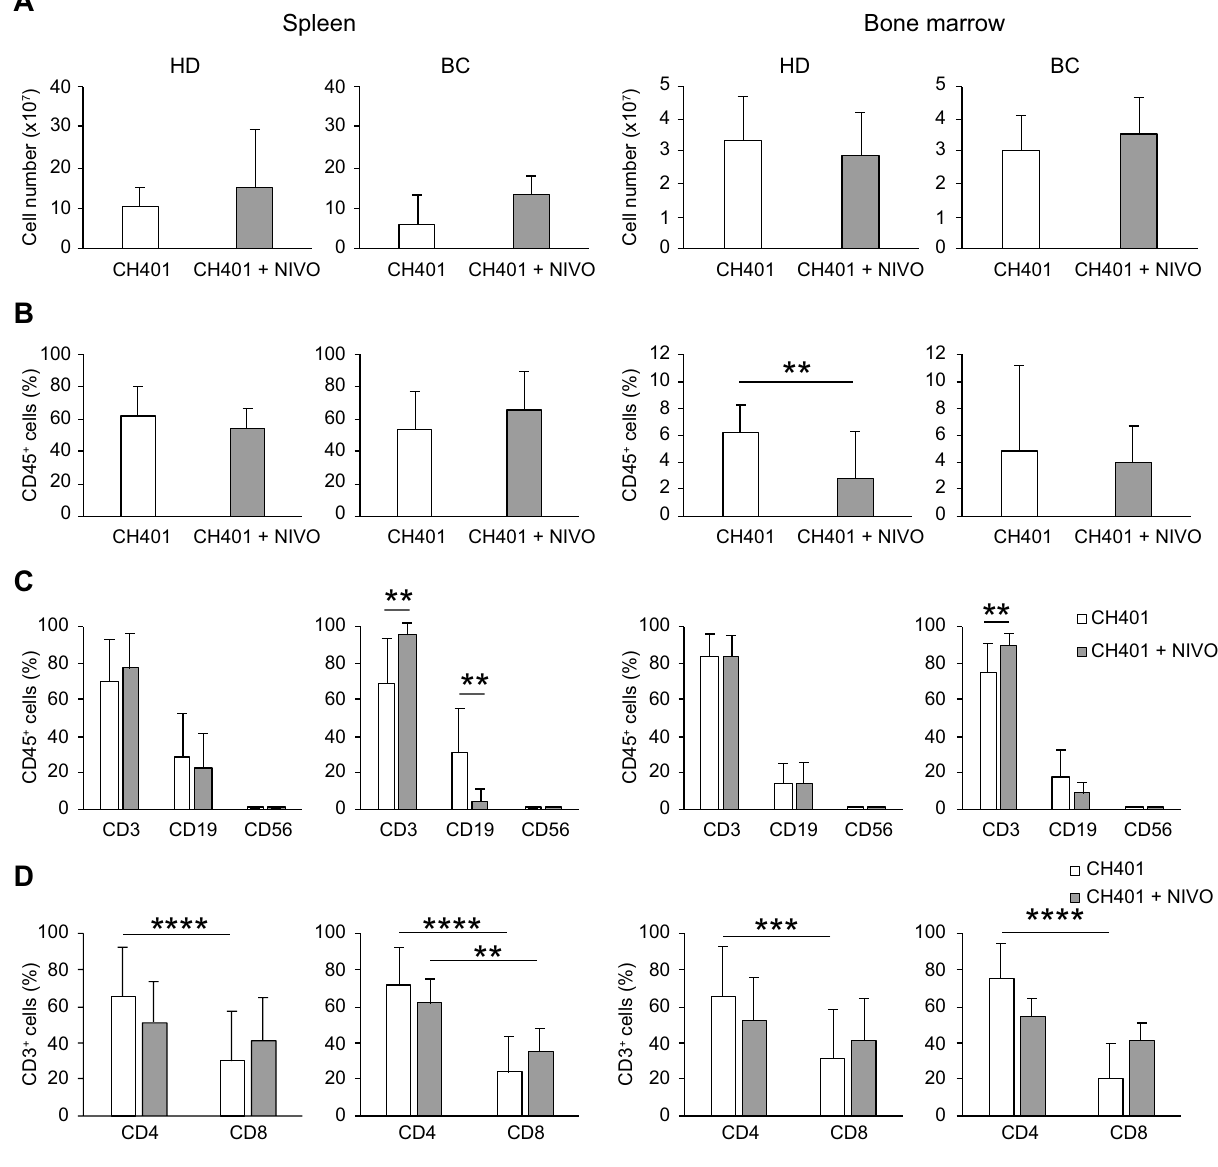
Figure 5. Effects of nivolumab on the cellularity of engrafted human cells. Nivolumab (NIVO) effects on human lymphocytes localized in the spleen and bone marrow were compared between HD-M (CH401MAP; n = 17, CH401MAP + NIVOb; n = 7) or BC-M (CH401MAP; n = 13, CH401MAP + NIVO; n = 6). CH401MAP and CH401MAP + NIVO administration shown as white (CH401MAP) or gray (CH401MAP + NIVO) bars. (A) Cell number of the spleen and bone marrow. (B) Percentage of human CD45 + cells. ** p = 0.01. (C) Percentage of each subset of lymphocytes, CD3 + T cells, CD19 + B cells, and CD56 + natural killer cells. ** p = 0.01. (D) Percentage of CD4 + and CD8 + T cells. * p = 0.05, ** p = 0.01, *** p = 0.001, **** p = 0.0001. BC breast cancer; HD healthy